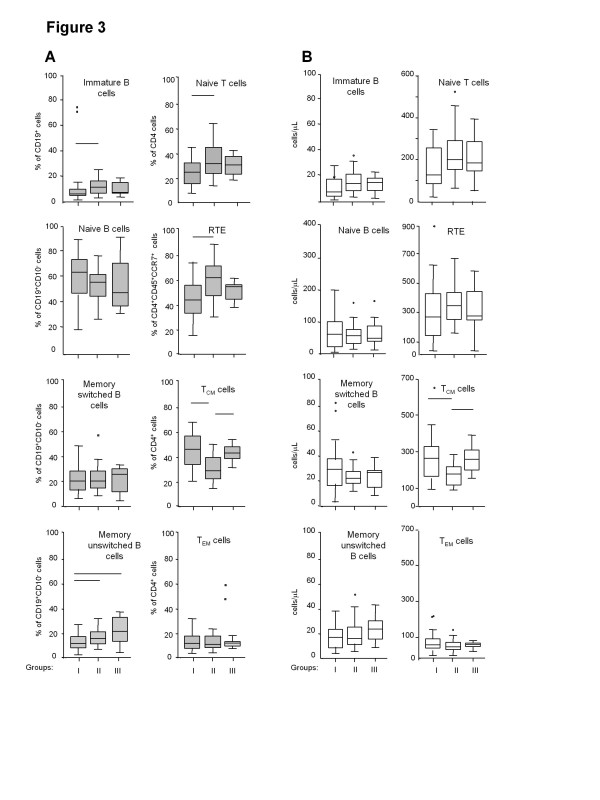
Quantification of B- and T-cell subpopulations. (A) Percentage (gray boxes) and (B) number (clear boxes) of immature, naive, memory switched, and memory unswitched B cells, as well as of naive, recent T emigrants (RTE), central memory (TCM) and effector memory (TEM) T cells in patients treated for 72 months with cART (group I), patients not requiring therapy (group II), and non-infected individuals (group III). Horizontal lines indicate the significant differences (all p < 0.05).